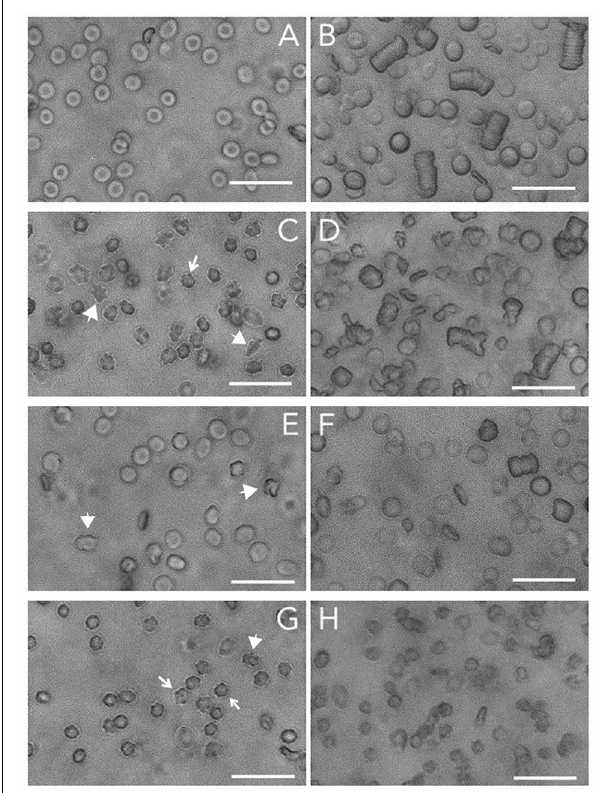
FIGURE 1 | Brightfield microscopy of RBCs and RBC aggregates. Microscopic analyses of RBCs and aggregates were performed by a ZOE Fluorescent Cell Imager (Bio-Rad Laboratories, Hercules, CA, United States). Packed RBCs (1 µ L) were resuspended in 199 µ L of non-aggregating solution (Ringer) and transferred to an ibidi µ -slide. For aggregation analysis, 2.5 µ L of packed RBCs were resuspended in 247.5 µ L of plasma. The sample was transferred to an ibidi µ -slide and left for 120 s to allow the RBCs to aggregate. (A) control RBCs; (B) aggregates of control RBCs; (C) RBCs from a neuroacanthocytosis patient; (D) RBCs of a neuroacanthocytosis patient after aggregation; (E,F) , control RBCs after treatment with orthovanadate before (E) and after aggregation (F) ; (G,H) control RBCs after treatment with DIDS before (G) and after aggregation (H) . The arrows indicate the echinocytes, the large arrowheads point to misshapen RBCs. Treatments were performed as described before (Cluitmans et al., 2012). The length of the bar is 25 µ m. Blood was obtained with informed consent and the studies were carried out as described before (De Franceschi et al., 2011; Dinkla et al., 2012; Cluitmans et al., 2015, 2016), in accordance with the CCMO guidelines of the Medical Ethical Committee of the Radboud University Medical Center